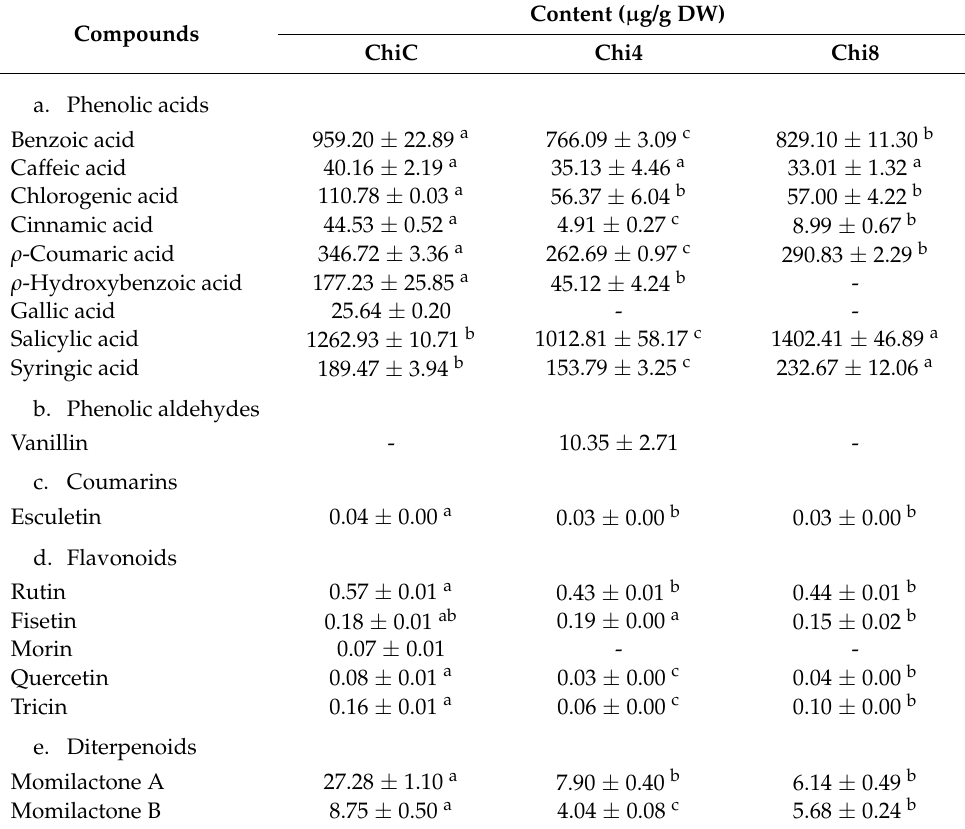
Table 3. Changes in chemical contents of rice seedlings in response to chilling